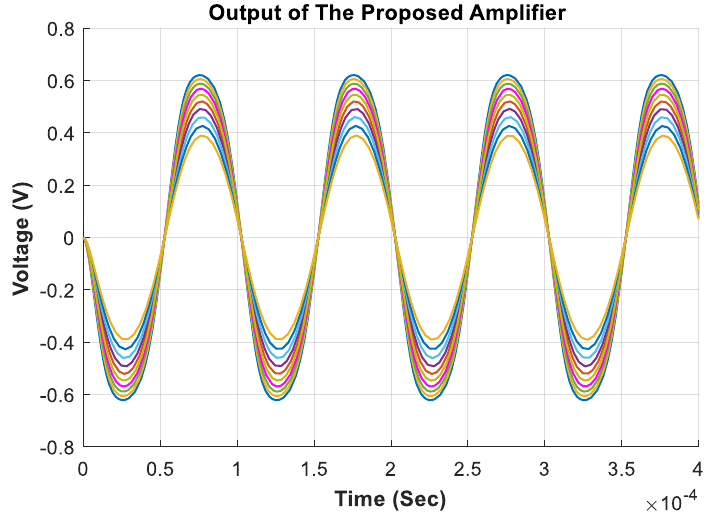
Figure 14. The output voltage of the proposed amplifier for differential input. Table 6. The specifications of the proposed self-biased inverter-based amplifier.